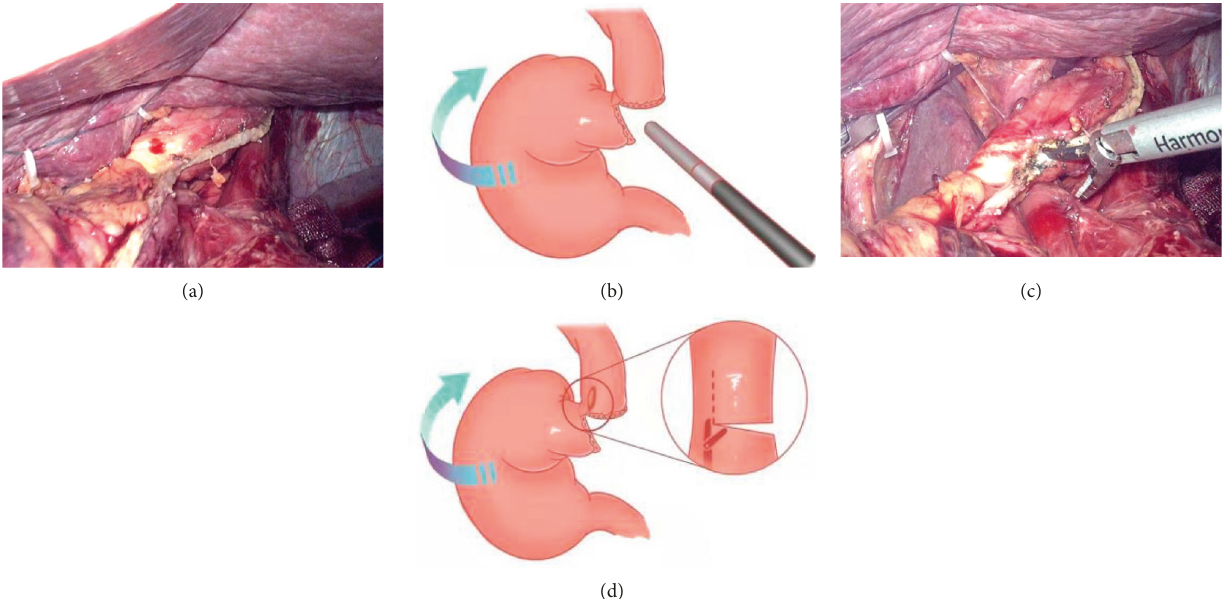
Figure 2: (a, b) The linear stapler transected the lower esophagus segment. (c, d) Ultrasonic knife perpendicular to the esophageal tangent to take a longitudinal hole, with the position under the action of gravity to produce downward-to-right traction.